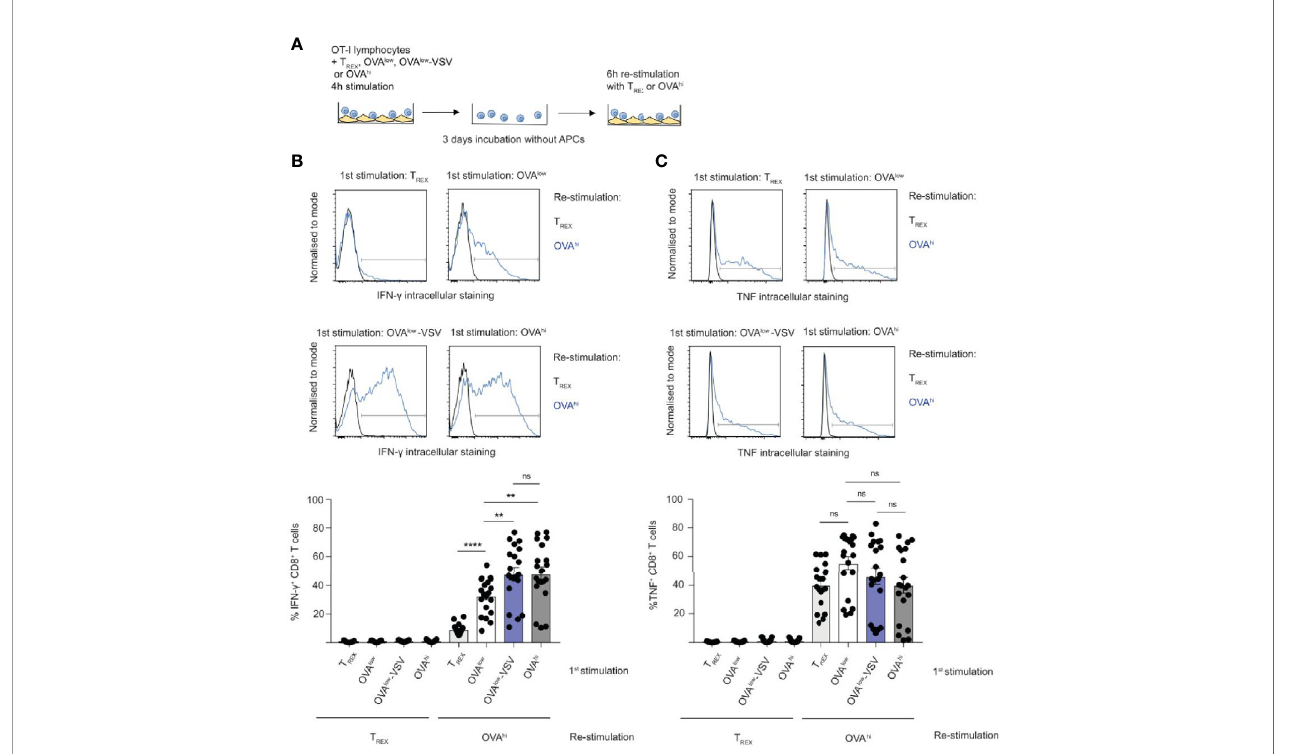
FIGURE 4 | Co-agonism enhances CD8 + T cell effector differentiation. (A) Ex vivo OT-I lymphocytes were stimulated with the indicated CHO APCs for 4h, cultured for 3 days without APCs, followed by 6h re-stimulation with T REX or OVA hi APCs. IFN- g (B) and TNF (C) production by CD8 + T cells was quanti fi ed using intracellular staining. Data from 19 mice from 4 independent experiments, representative fl ow cytometry plots are shown. Statistical signi fi cance was calculated using one-way ANOVA, with Tukey ’ s multiple comparisons test. **P < 0.01, ****P < 0.0001, ns, P ≥